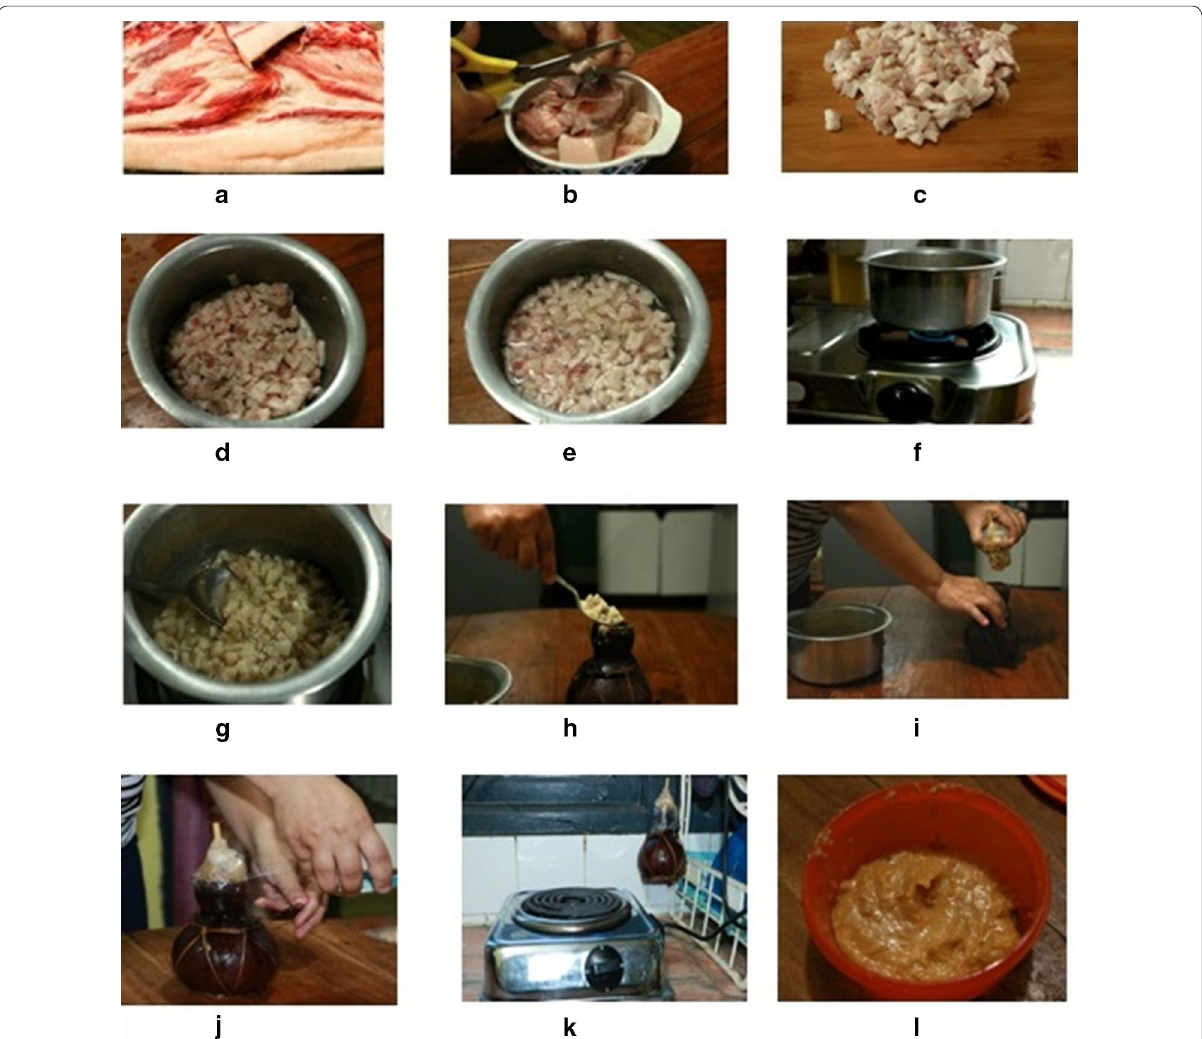
Fig. 2 Different steps involved in sa - um preparation. a Pork lard, b – d mincing of lard, e – g added water and cooked till water evaporates out, h – j cooked lard transferred to cleansed and dried ‘Um’, k incubated at fireplace or sun, l finished product sa -